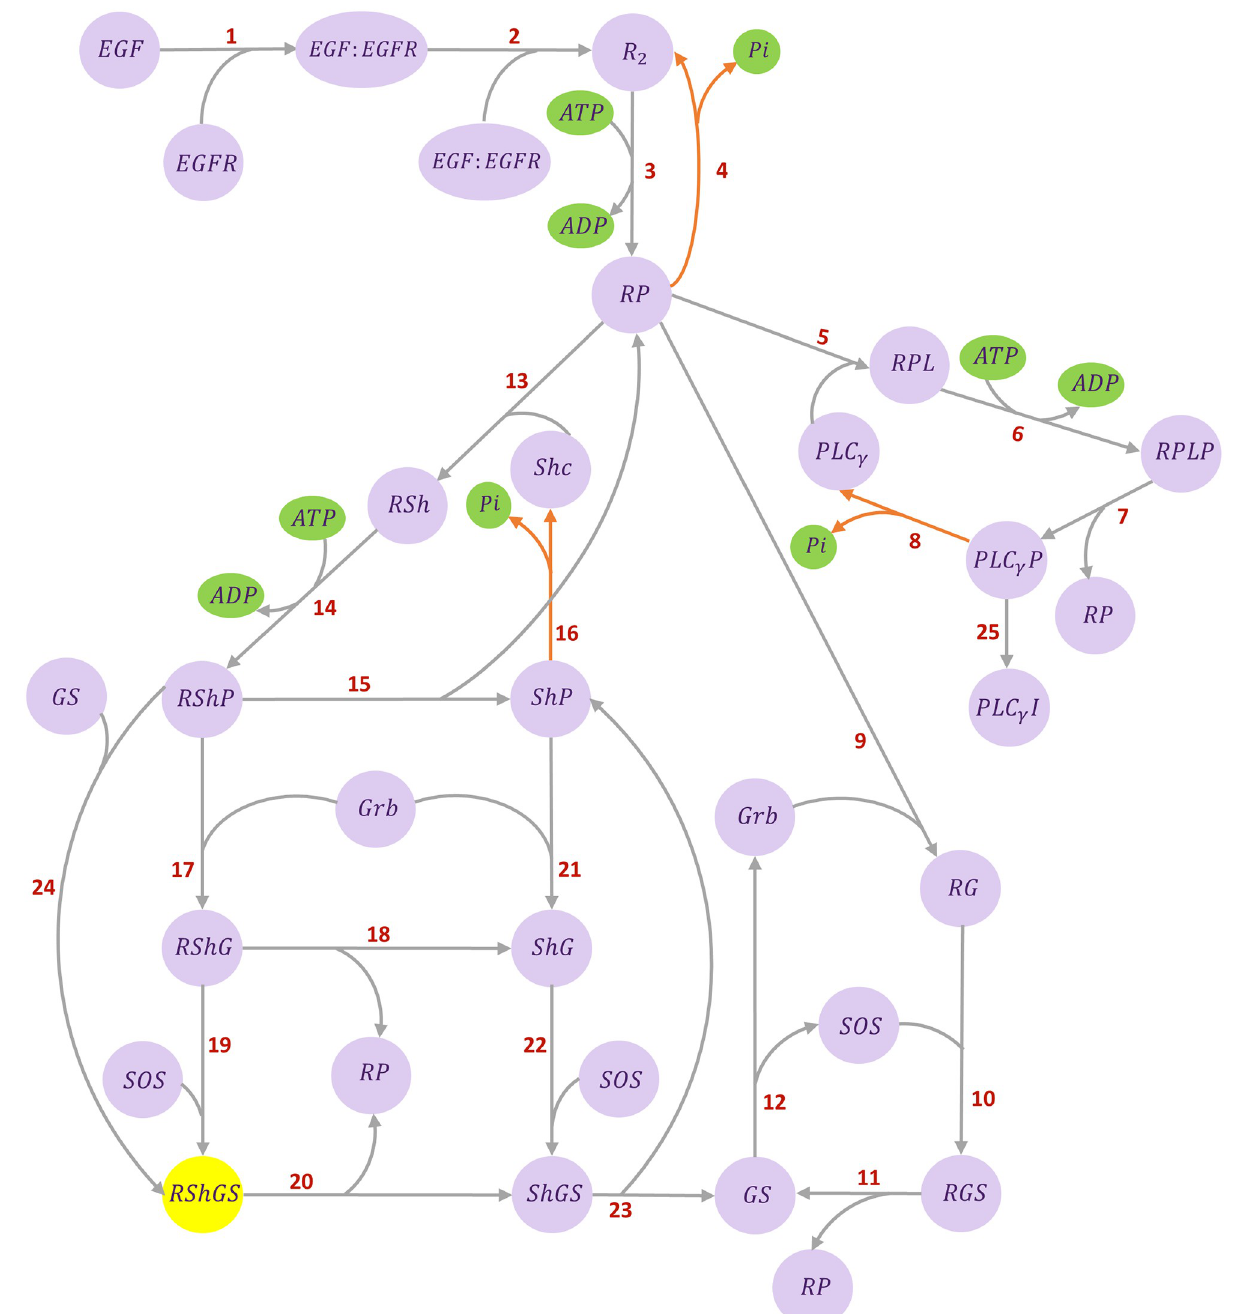
Fig 3. Kinetic structure of the EGFR pathway. The ATP hydrolysis species are shown in green (involved in phosphorylation and dephosphorylation reactions). The RShGS complex in yellow is mutual between the EGFR pathway and the Ras activation models. The reactions are numbered as the equations in the CellML source code. Steps 4, 8, 16 in orange represent the irreversible reactions. The network was adapted from [30].